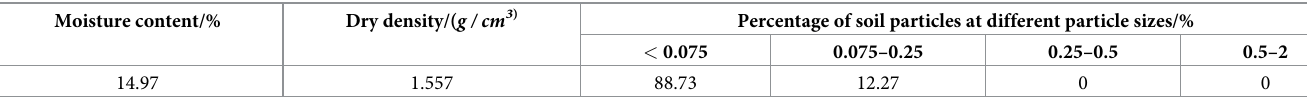
Table 1. Basic physical parameters of soil samples. Moisture content/% Dry density/( g / cm 3